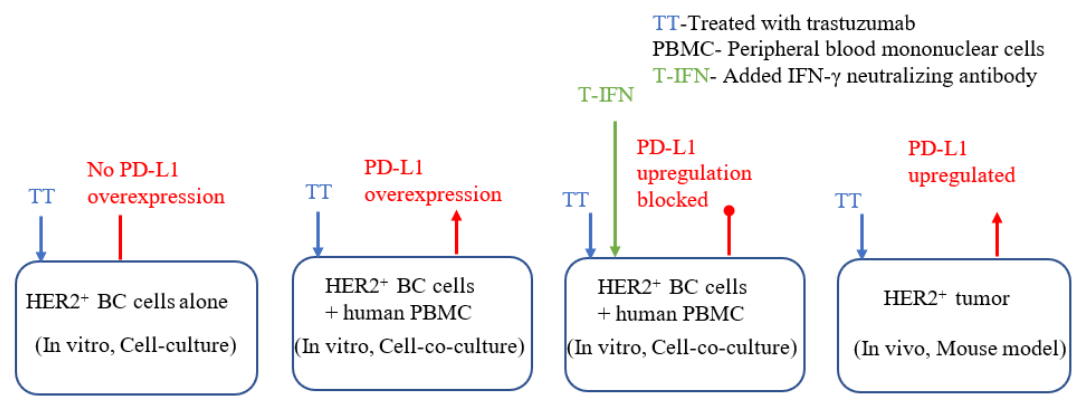
Figure 5. Expression of PD-L1 in different in vitro and in vivo settings [134]. IFN: interferon-gamma, BC: breast cancer.